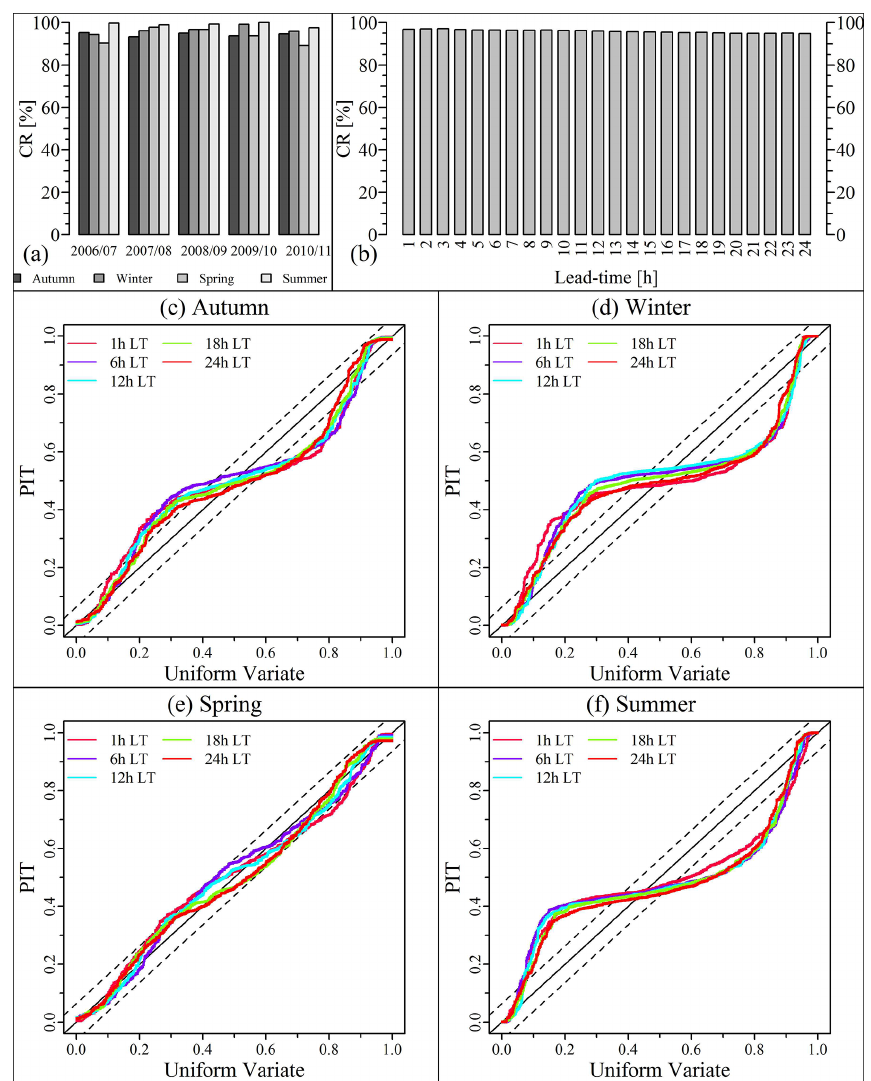
Figure 9. Reliability score (containing ratio CR) for 95% prediction interval for (a) each season of every hydrologic year, and (b) different forecast lead times based on entire series. In (c) – (f) sample PIT uniform probability plots for each of the four seasons at 1, 6, 12, 18 and 24h forecast lead times. Solid line designates the theoretical uniform distribution, broken lines represent the Kolmogorov significance band, and the dots denote PIT value of the observed p